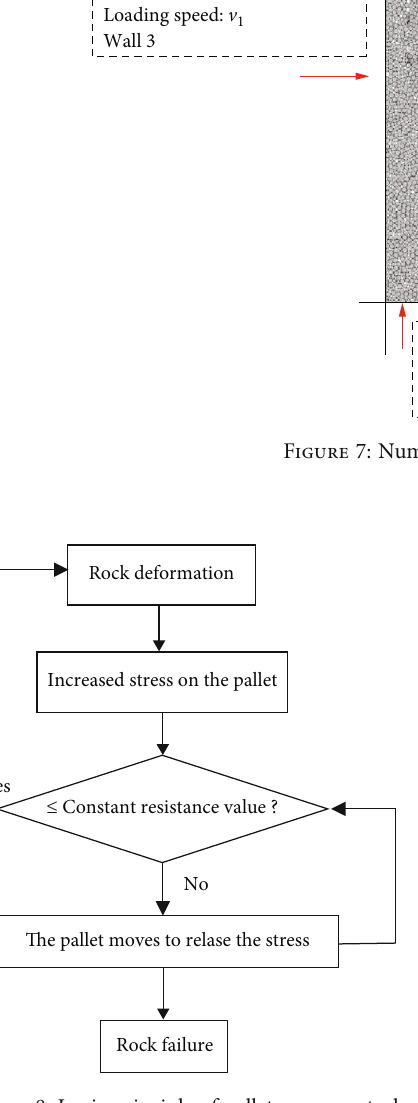
Figure 8: Logic principle of pallet servo